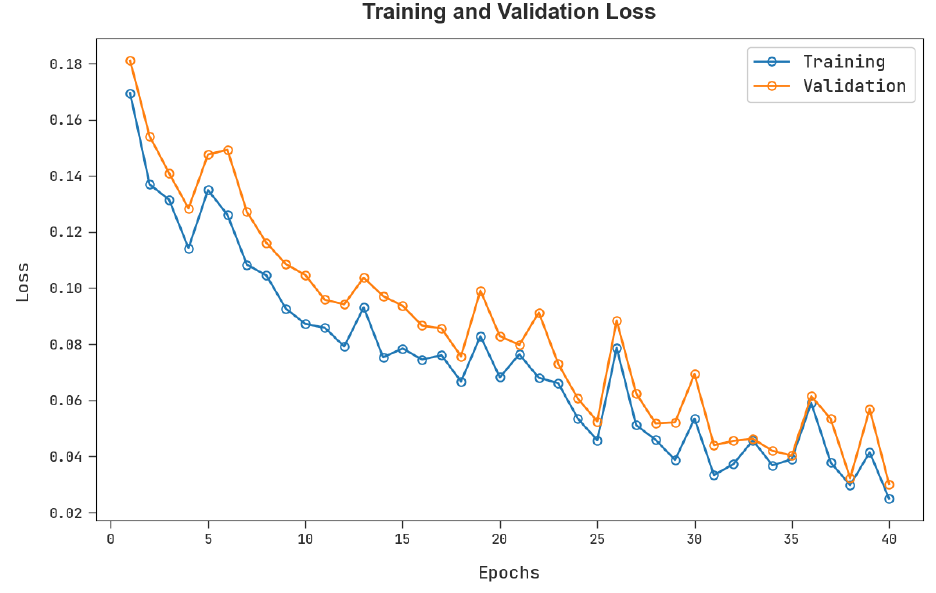
Figure 6. 𝑇𝑅 𝑙𝑜𝑠𝑠 and 𝑉𝐿 𝑙𝑜𝑠𝑠 analysis of AOEDBC-DL system.